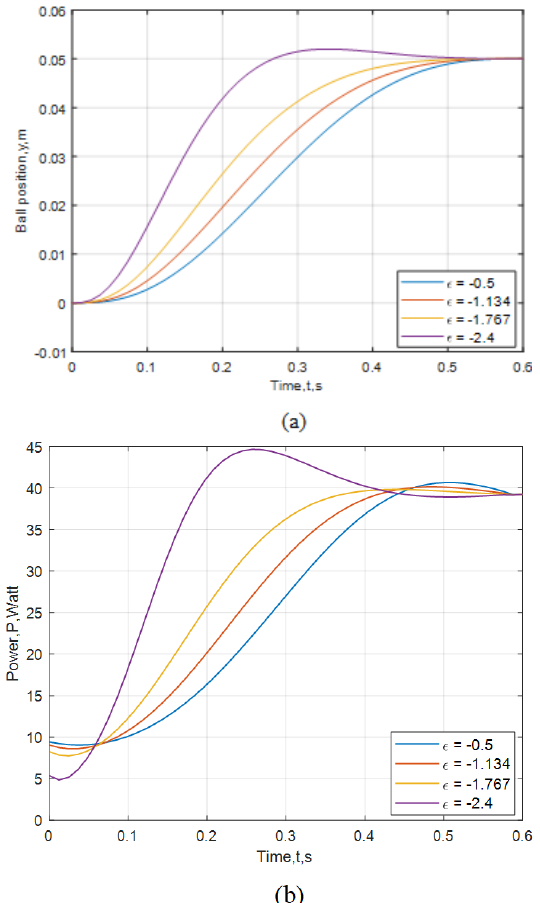
Fig 3. Re-shaping ball position profile by varying expo– nenttial factor ε : a) reference ball position vs. time, b) reference electrical power vs. time.